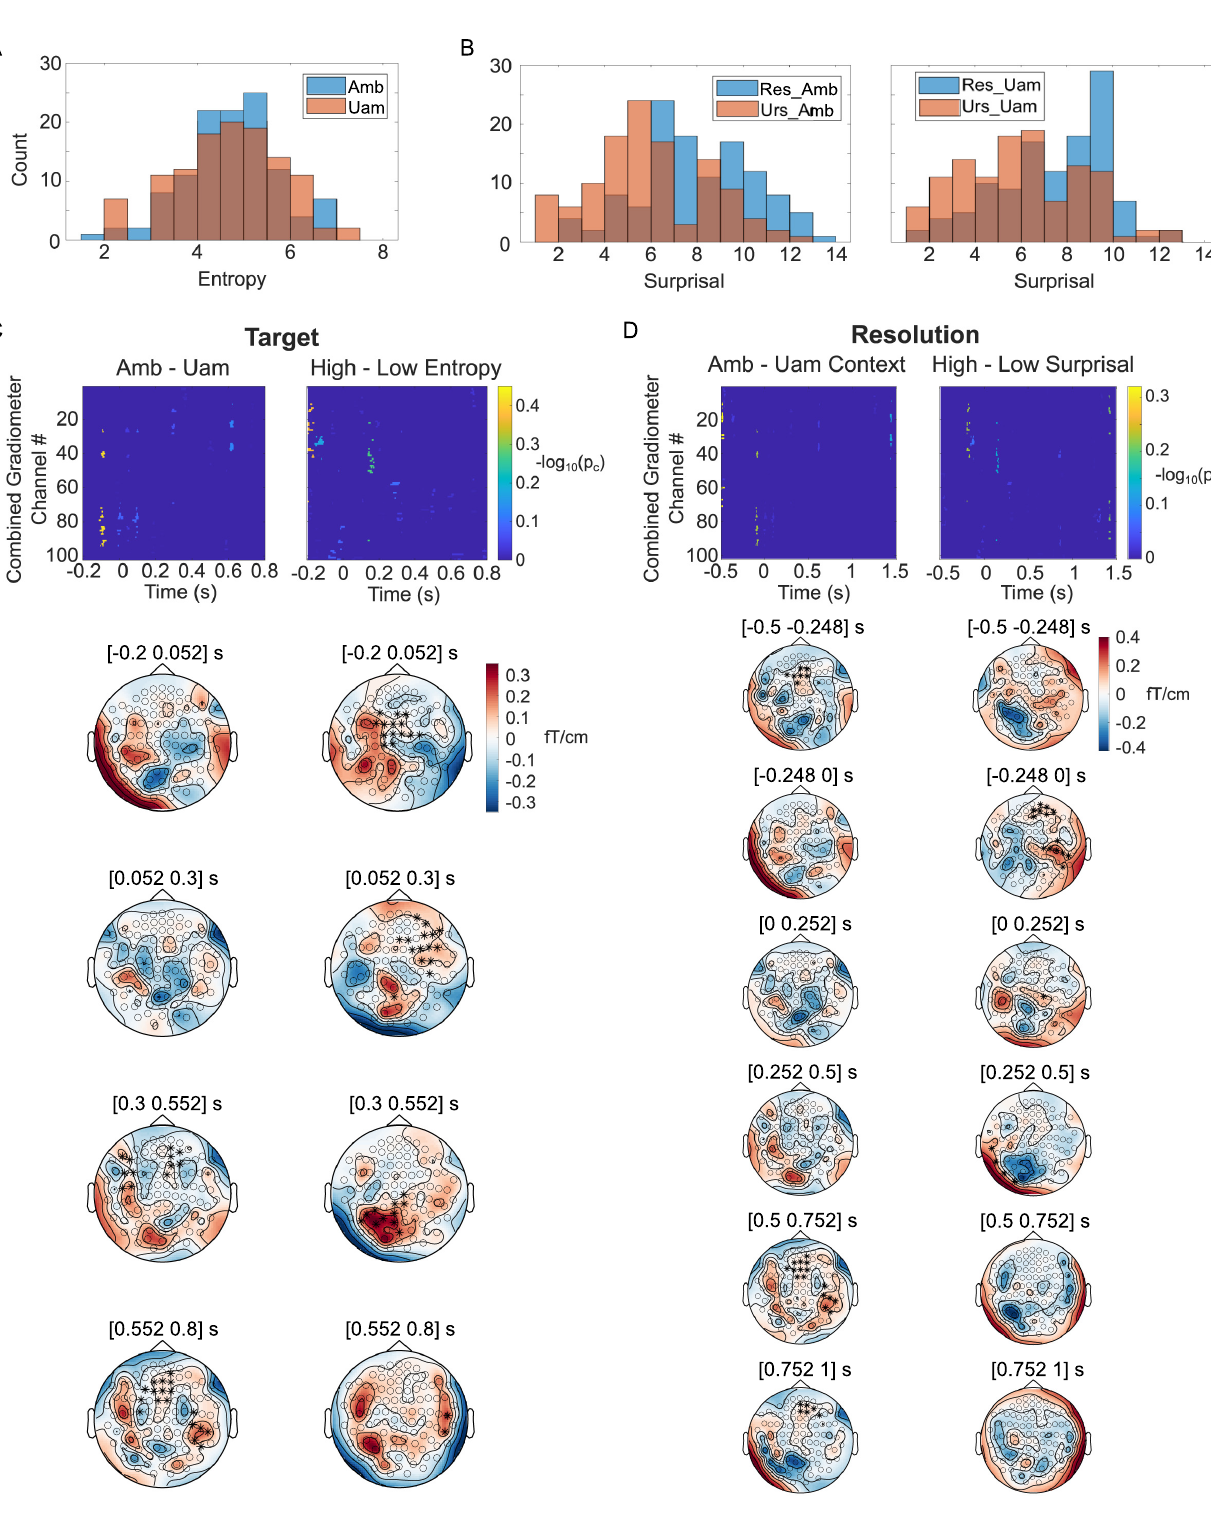
PLOS Biology | https://doi.org/10.1371/journal.pbio.3002046 March 22,